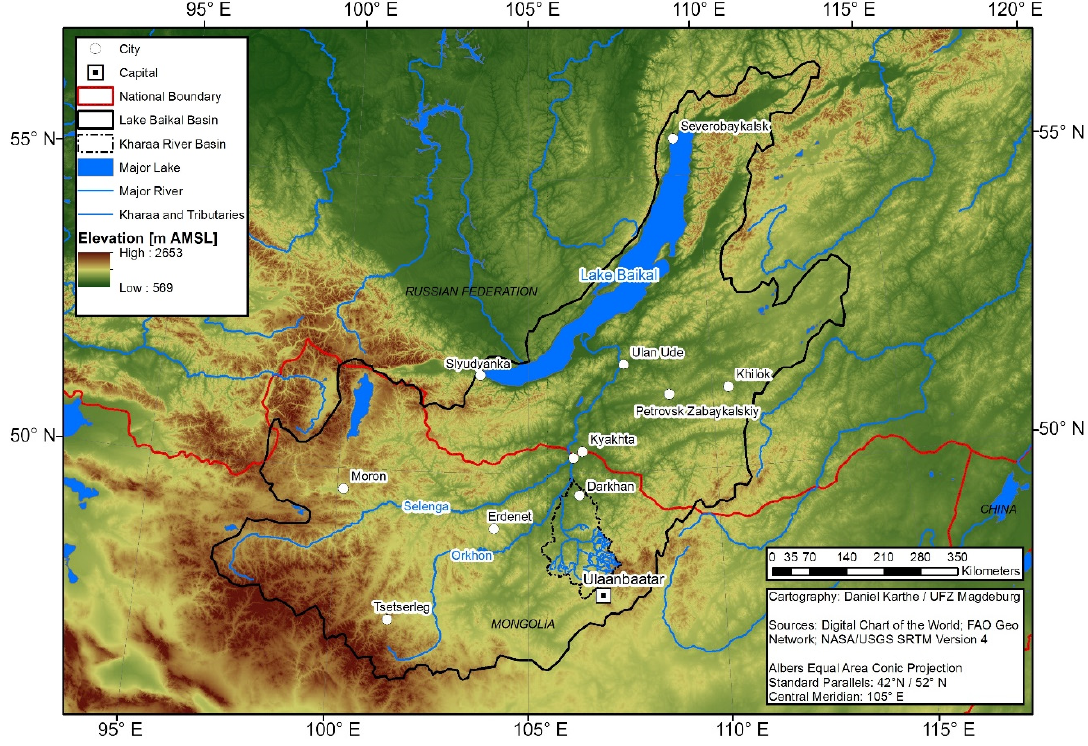
Figure 1. Location of the Kharaa River Basin within the Mongolian Plateau.